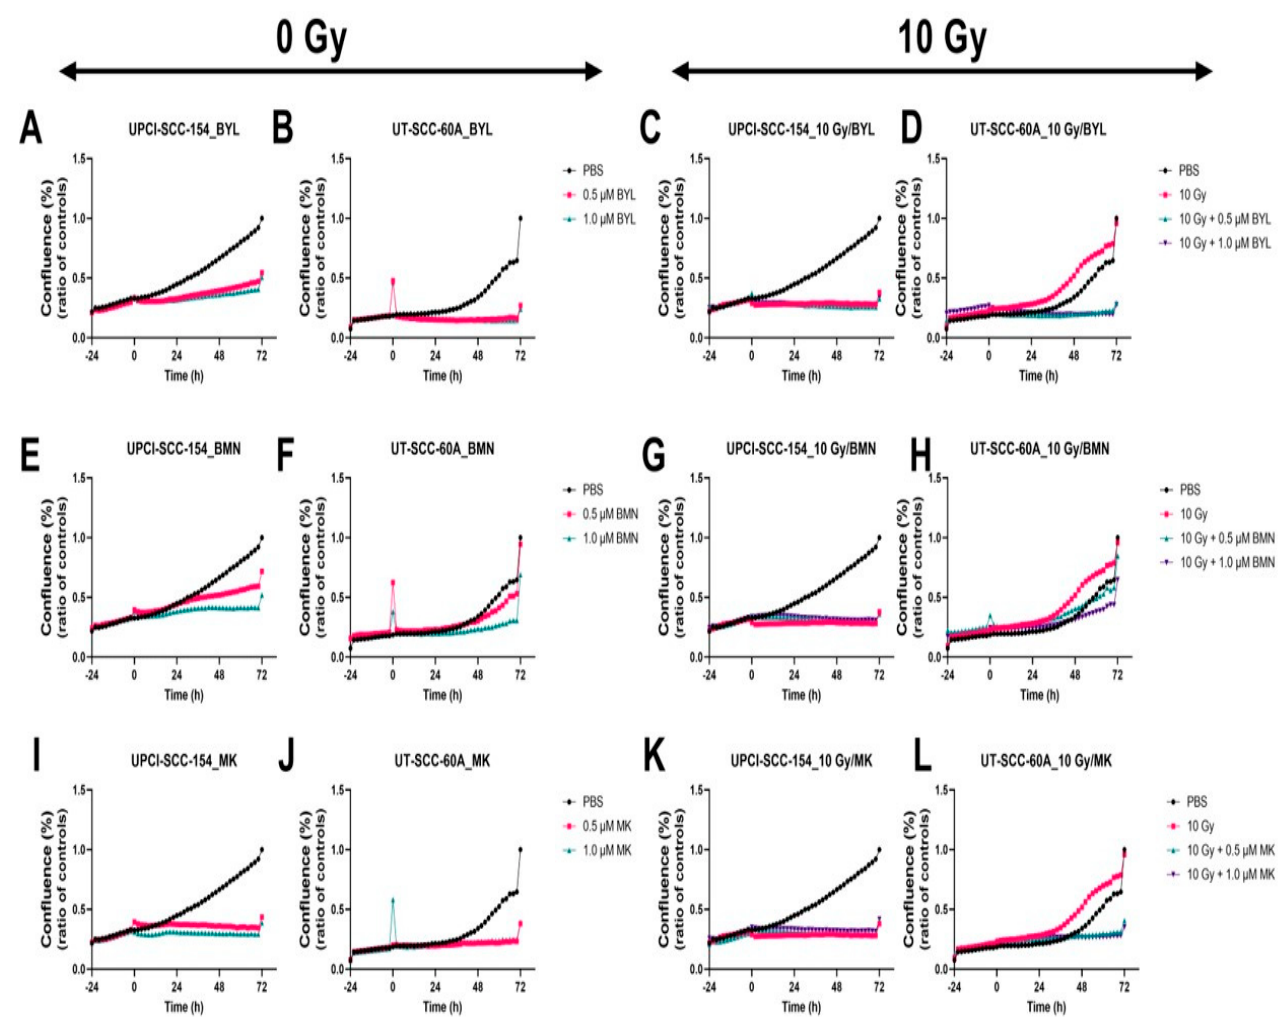
Figure 6. Proliferation responses of the HPV+ UPCI-SCC-154 and HPV − UT-SCC-60A cell lines upon treatment with BYL719 with/without (w/wo) 10 Gy ( A – D ), BMN-673 w/wo 10 Gy ( E – H ), or MK-1775 w/wo 10 Gy ( I – L ). The graphs represent one experimental run per cell line. Confluence (%) denotes the proliferation response, BYL denotes BYL719, BMN denotes BMN-673, and MK denotes MK-1775.